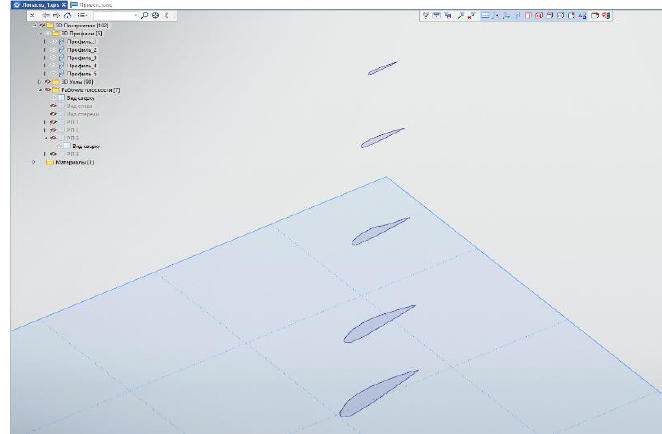
Fig. 12 . "Blade_1" part from the ELC